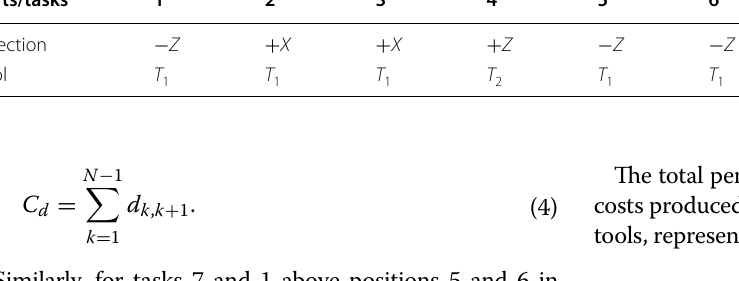
Table 3 The disassembly information of the example product from Figure 1